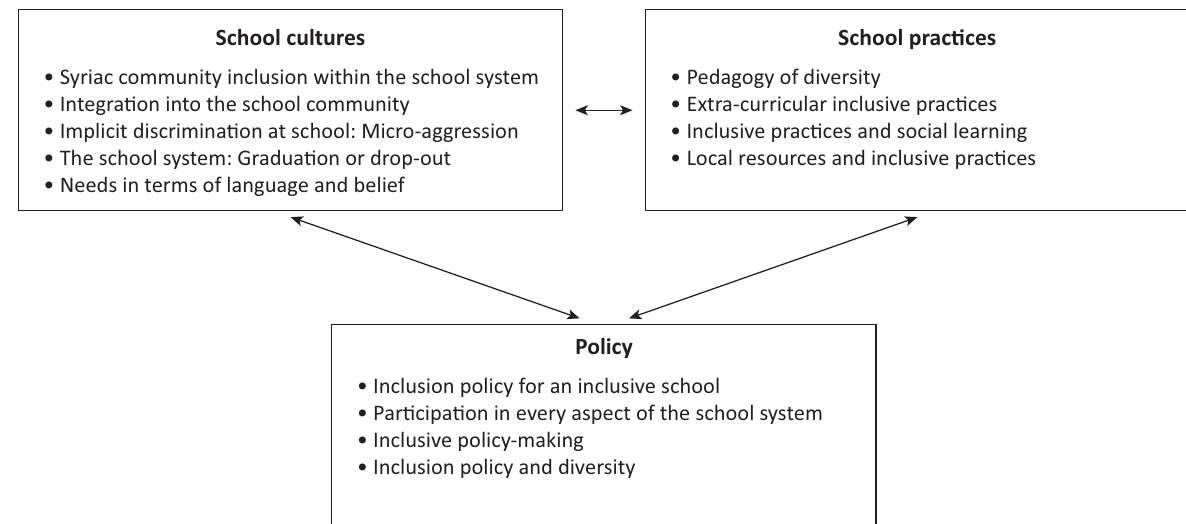
Figure 1. Map illustrating themes and sub-themes created out of the analysis of interview